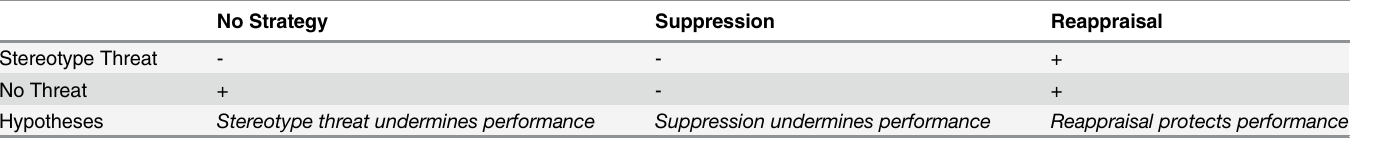
Table 1. Predicted Relative Performance Levels of the Experimental